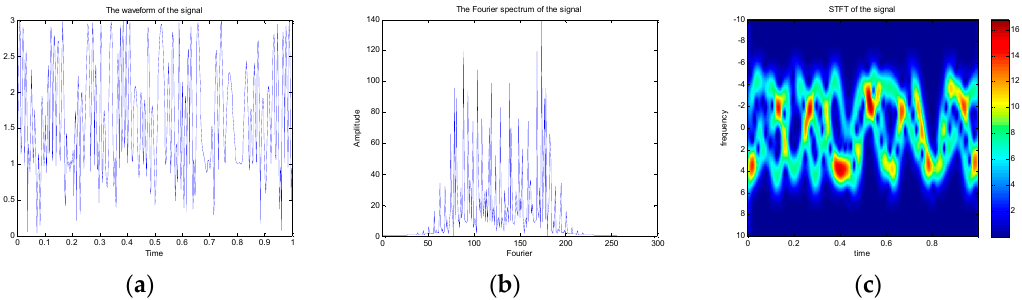
Figure 4. The simulated signal: ( a ) waveform; ( b ) Fourier spectrum; ( c ) STFT (short time Fourier transform).